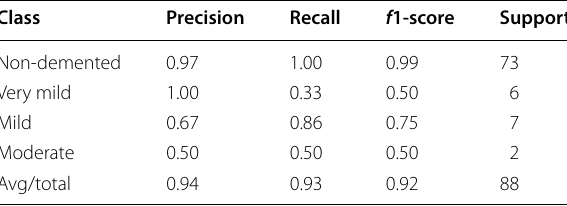
Table 6 Performance of the proposed ensembled